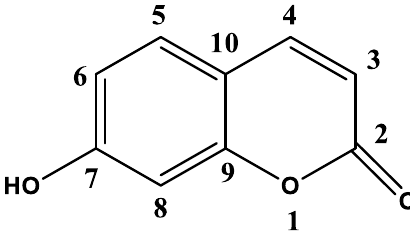
Figure 1. Structure of pure isolated umbelliferone (UFN).